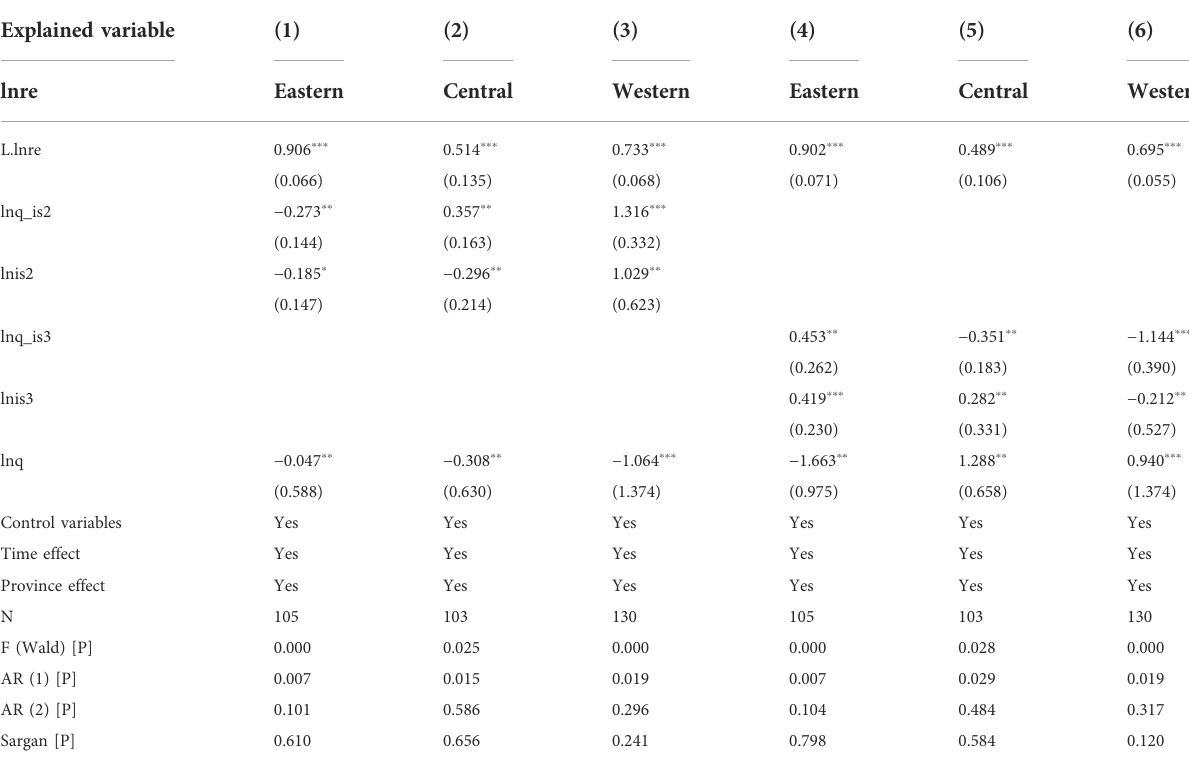
TABLE 4 Estimated results of the industrial structure in fl uences (2). Explained